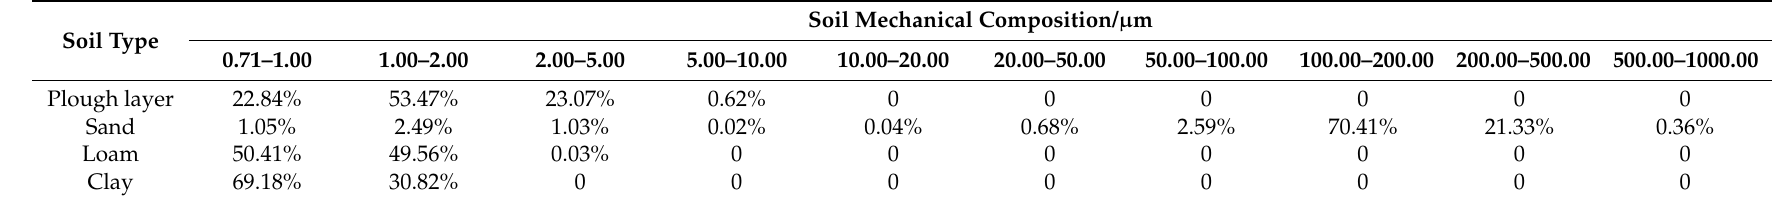
Table 1. Mechanical composition of three soil profile